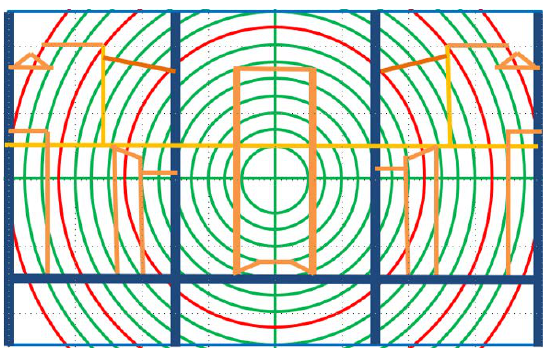
Figure 20. Grids and circles together. Source: the author.